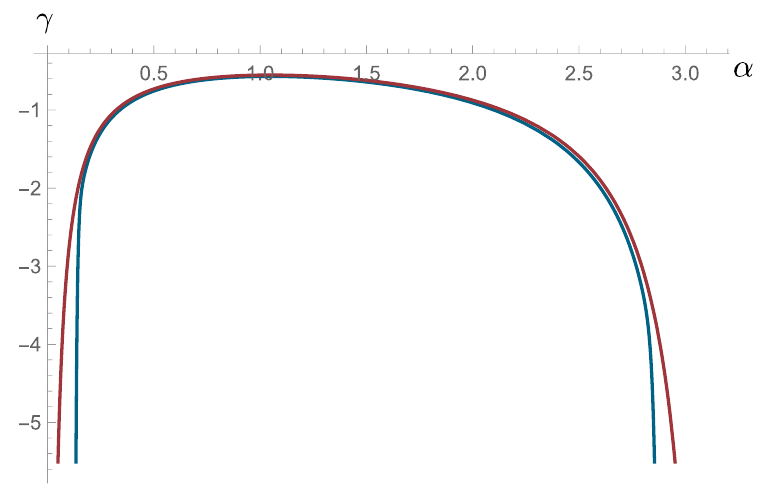
Figure 2 . EE for isosceles triangle: comparison between our results (in red) given by S A − √ π P ( α ; h ) in equation (7.9) and the prediction from numerical results (in blue) in 6